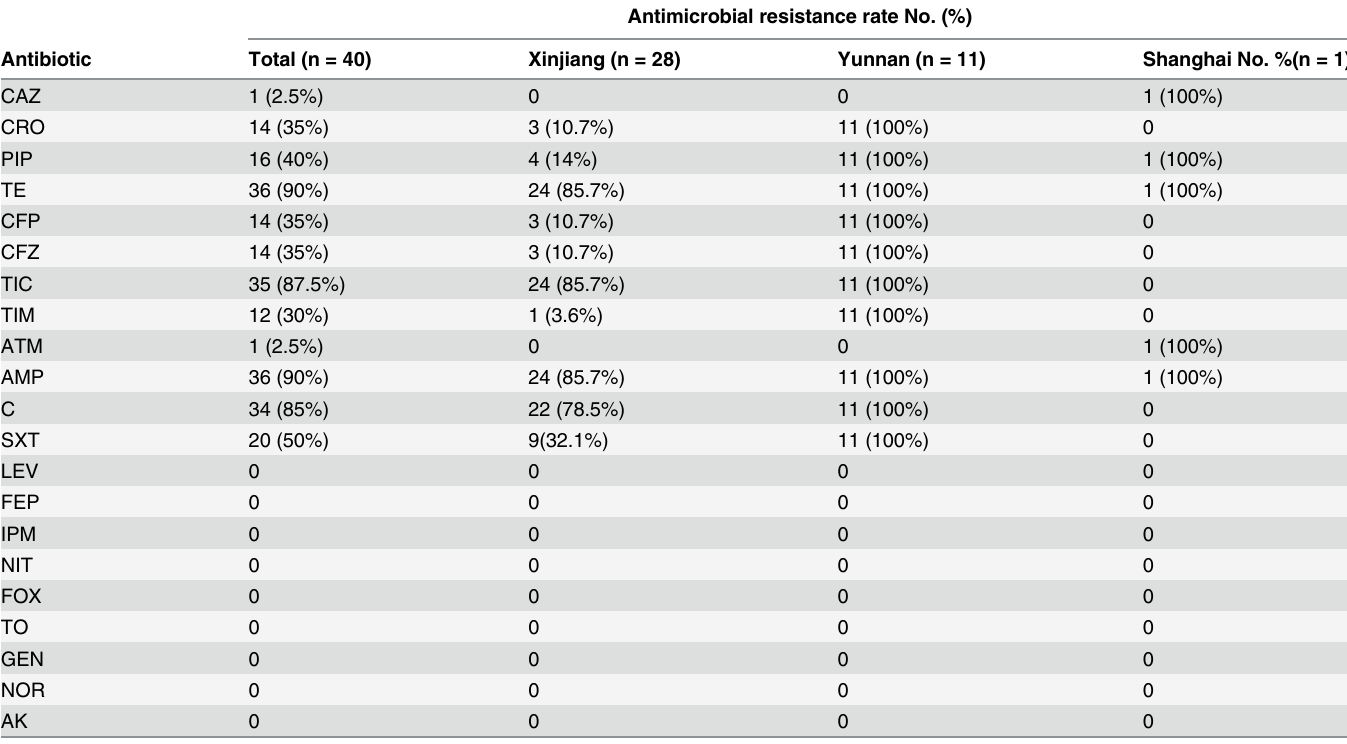
PFGE was performed to determine the genetic diversity of the S . flexneri 1b isolates. The 40 S . flexneri 1b isolates generated 18 PFGE patterns (Fig 1). All isolates could be divided into five main groups (A – E), with approximately 82% similarity. Notably, there was a high level of vari- ation in the PFGE profiles of serotype 1b isolates between different regions of China, which contrasted with a previous study showing that 70 S . flexneri 1b strains isolated in Bangladesh Table 4. Comparison of susceptibility to 21 antibiotics among S . flexneri 1b isolates from different regions. Antimicrobial resistance rate No. (%)